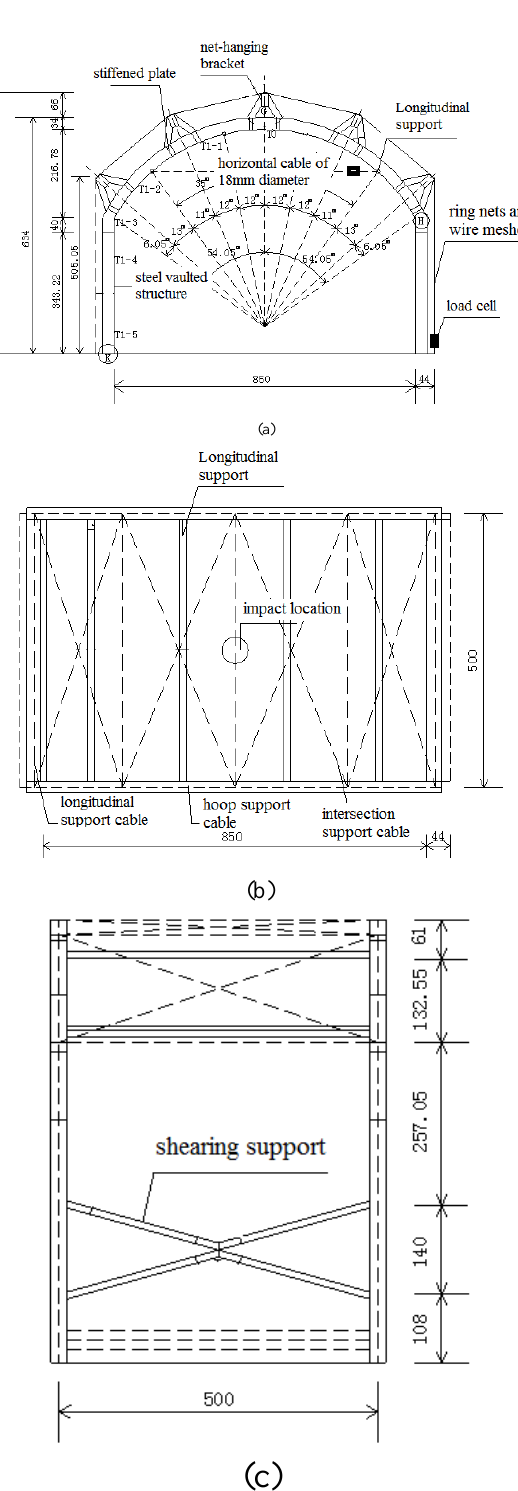
TS2: Please provide page range. Fig. 3. The design of a single-span flexible rock-shed (unit:cm). (a) The page range is 1 to 11. Fig.3. The design of a single-span flexible rock-shed (unit:cm). (a) Front view of the designed Front view of the designed flexible rock-shed. (b) Top view of the flexible rock-shed. (c) End view of the flexible rock-shed. flexible rock-shed; (b) Top view of the flexible rock-shed; (c) End view of the flexible rock-shed.